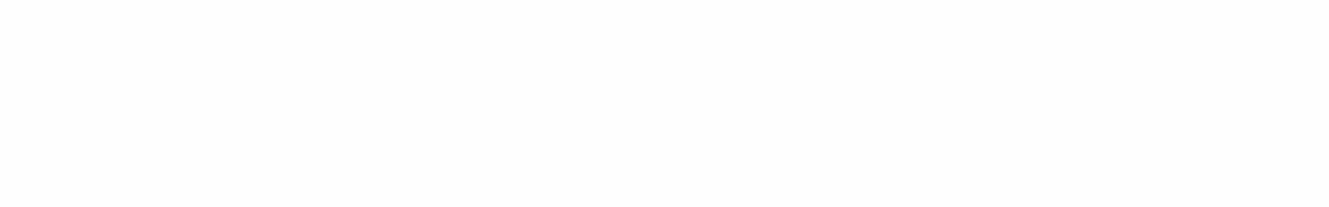
FIGURE 4 The stable and unstable manifolds of the saddle point in "cat map"